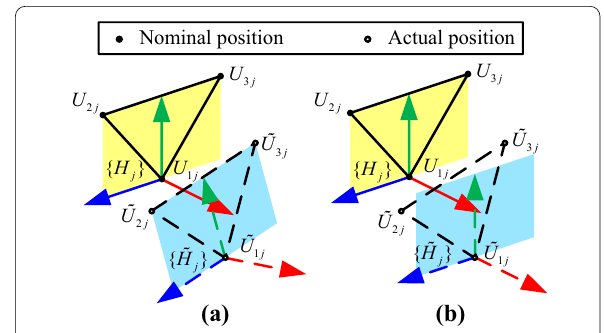
Figure 4 Two different ways to define the actual hip frame: a considering the orientation errors, b ignoring the orientation